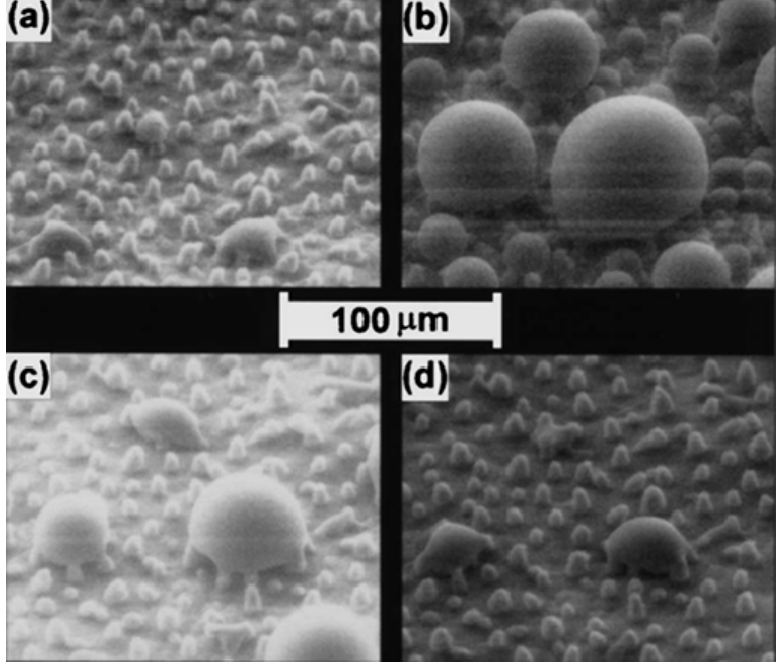
Figure 4. ESEM images captured during water condensation when droplets grow ( a , b ), and that during water evaporation when droplets shrink ( c , d ) on a lotus leaf. Images reprinted from [54], with permission from AIP Publishing LLC, Copyright